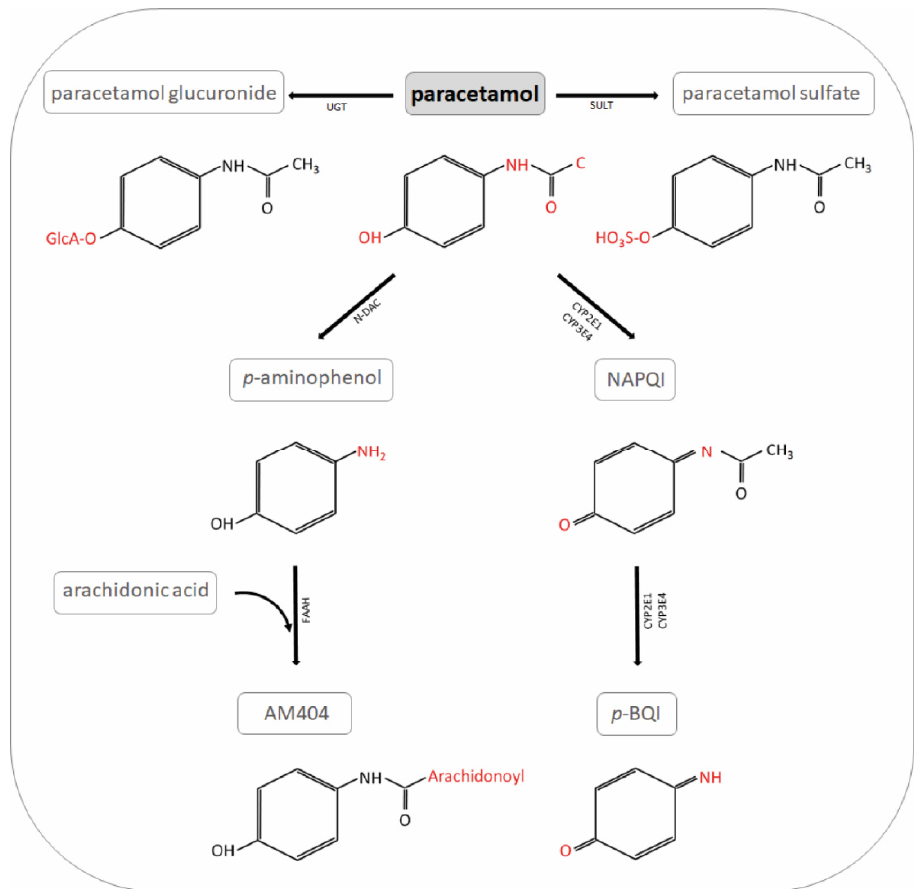
Figure 1. Paracetamol metabolites. NAPQI: N -acetyl- p -benzo-quinone-imine; UGT: UDP-glucuronyl transferase; SULT: sulfotransferase; N-DAC: N -deacetylase; GST: glutathione S-transferase; p -BQI: p -benzoquinone; FAAH: fatty acid amide hydrolase; AM404: N -arachidonoyl-phenolamine.